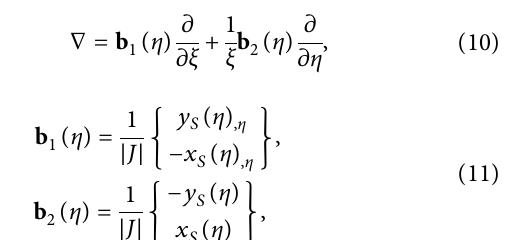
j on a circular cylinder for the